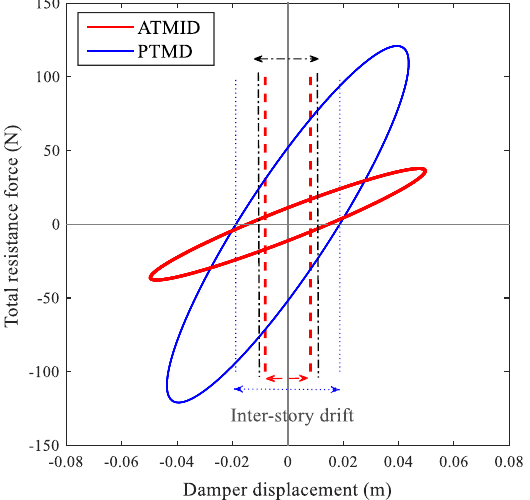
Figure 13. Total resistant force-displacement curve of PTMD and ATMID at frequency of 7.13 (rad/s).